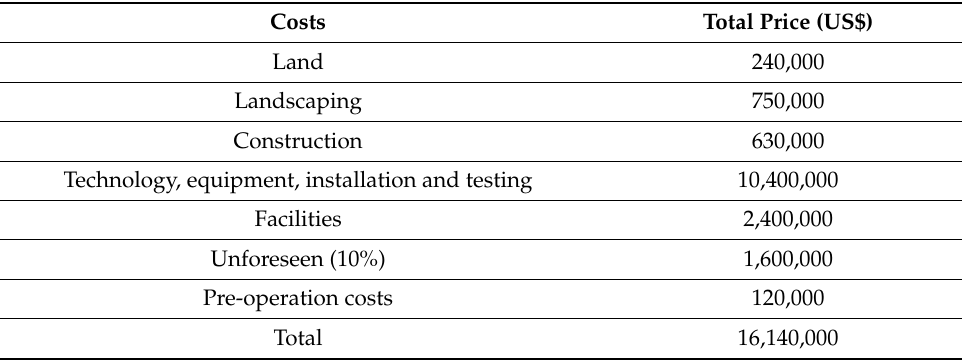
Table 6. CAPEX costs of a 10 MW solar power plant.